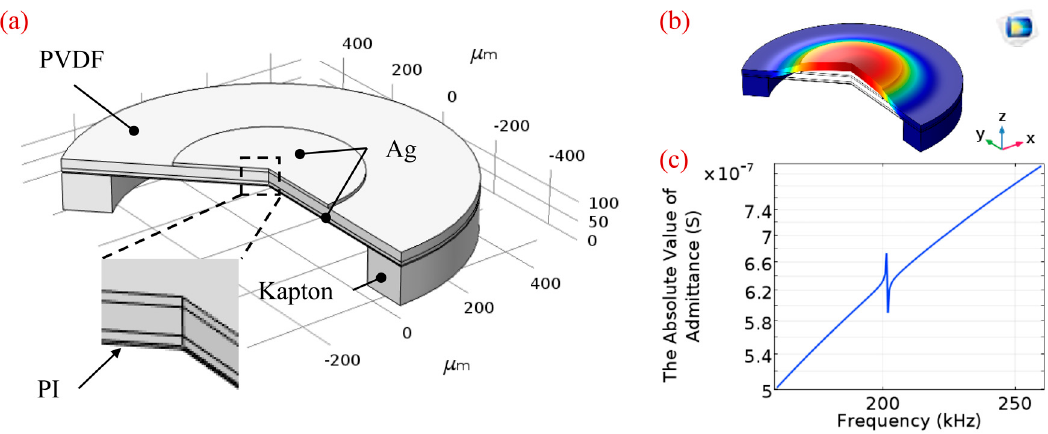
Figure 3. The FEA of the PMUT using COMSOL Multiphysics 5.3. ( a ) Simulation model; ( b ) vibration mode shape at the resonant frequency of 202.58 kHz; ( c ) the chart of the admittance. Table 1. The material properties used in FEA.